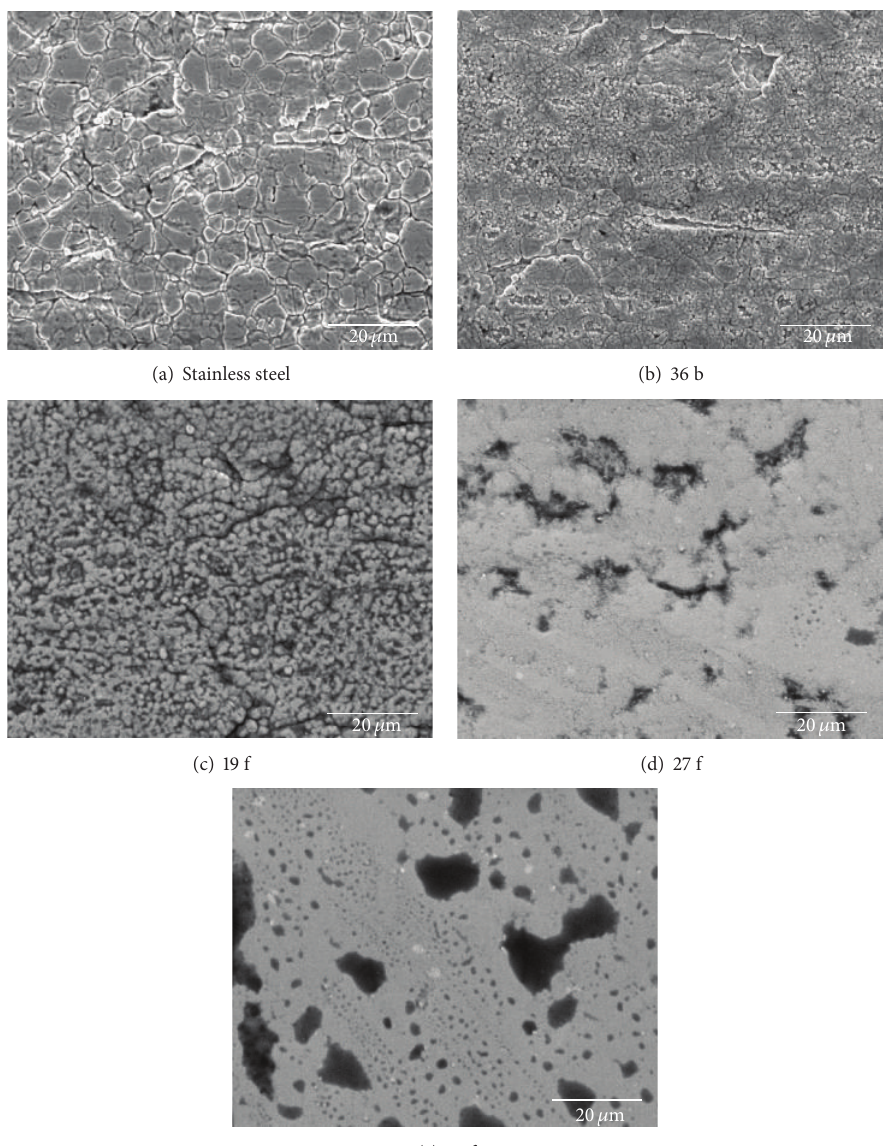
Figure 3: SEM images of sample surfaces. All the pictures are taken at 15.0 KV accelerating voltage and magnification 1500x.